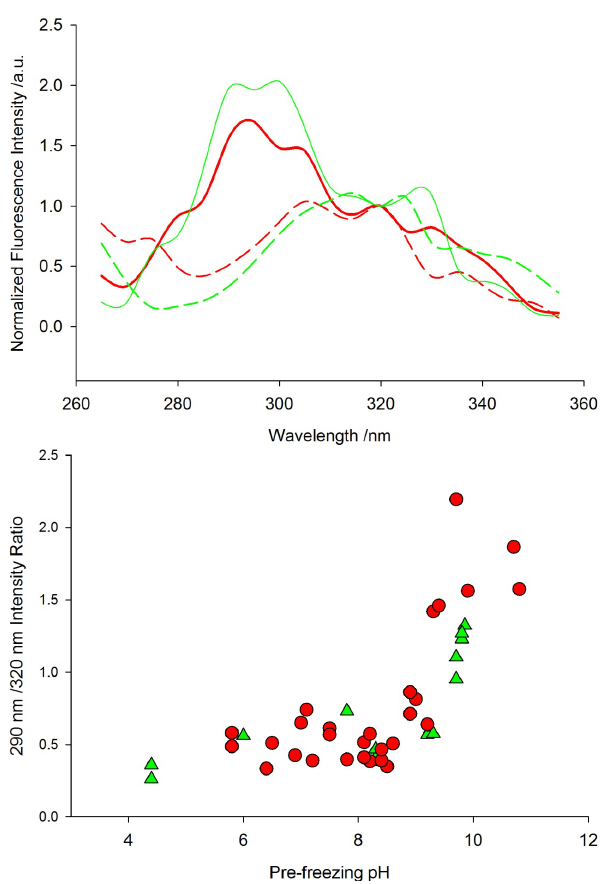
Fig. 1. (a) Harmine excitation spectra acquired at the frozen fresh- water surface (red traces) and at the frozen salt water (0.5MNaCl) surface (green traces) for strongly basic pre-freezing pH ∼ 9.8 (solid traces) and near-neutral pre-freezing pH (dashed traces). Spec- tra were collected by scanning the excitation wavelength in 5nm steps while monitoring harmine fluorescence at ∼ 430nm. (b) The harmine 290/320 intensity ratio measured at the frozen freshwater surface (red circles) and at the frozen salt water (0.5MNaCl) sur- face (green triangles) as a function of pre-freezing pH. Initial pre- freezing pH was adjusted with NaOH(aq) or HCl(aq) and measured with a commercial pH